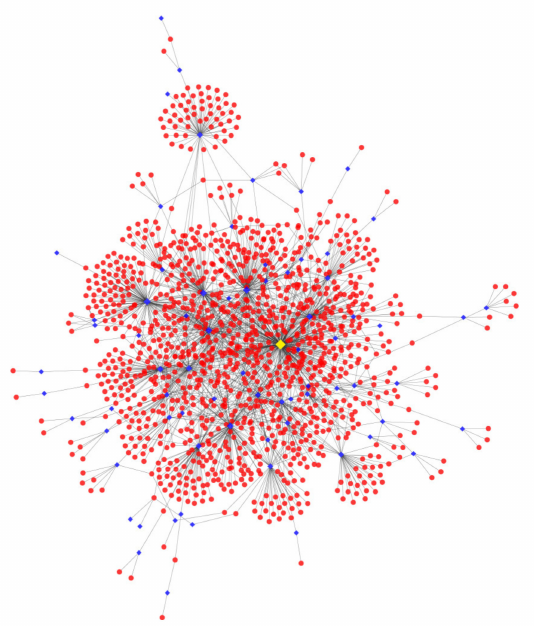
Figure 5. DEMs’ target genes regulatory network. The red circle represents target genes, the rhombus represents DEMs and the yellow rhombus represents